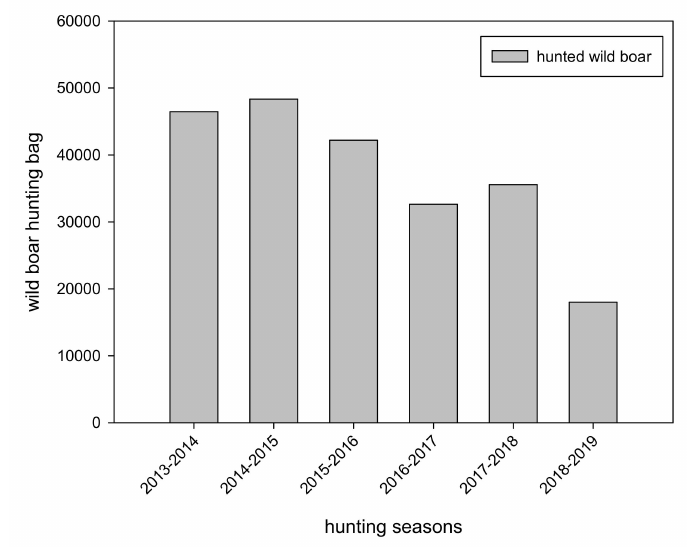
Figure 1. Hunting bag data of wild boar hunted in Lithuania (each hunting season is from April 15 to April 14 of the following year).